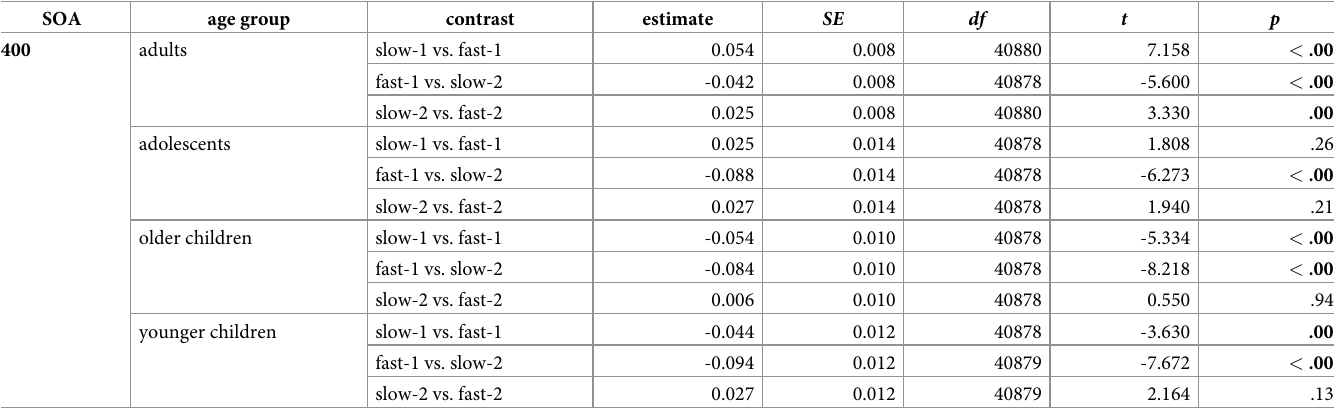
Table 2. Post-hoc contrasts of the age group × block sequence × SOA interaction effect of the IES model. SOA age